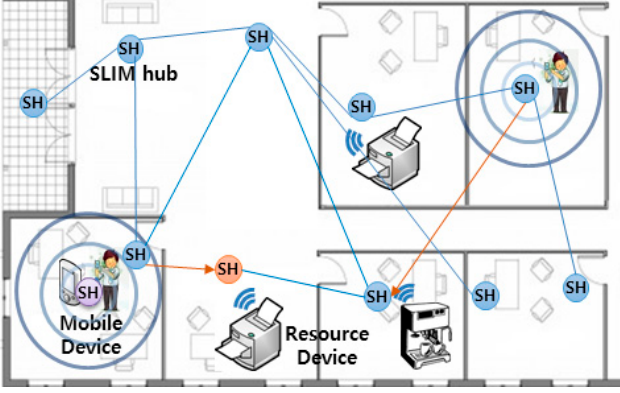
Figure 2. An example of a Self-Organizing Middleware Platform for a printing service.